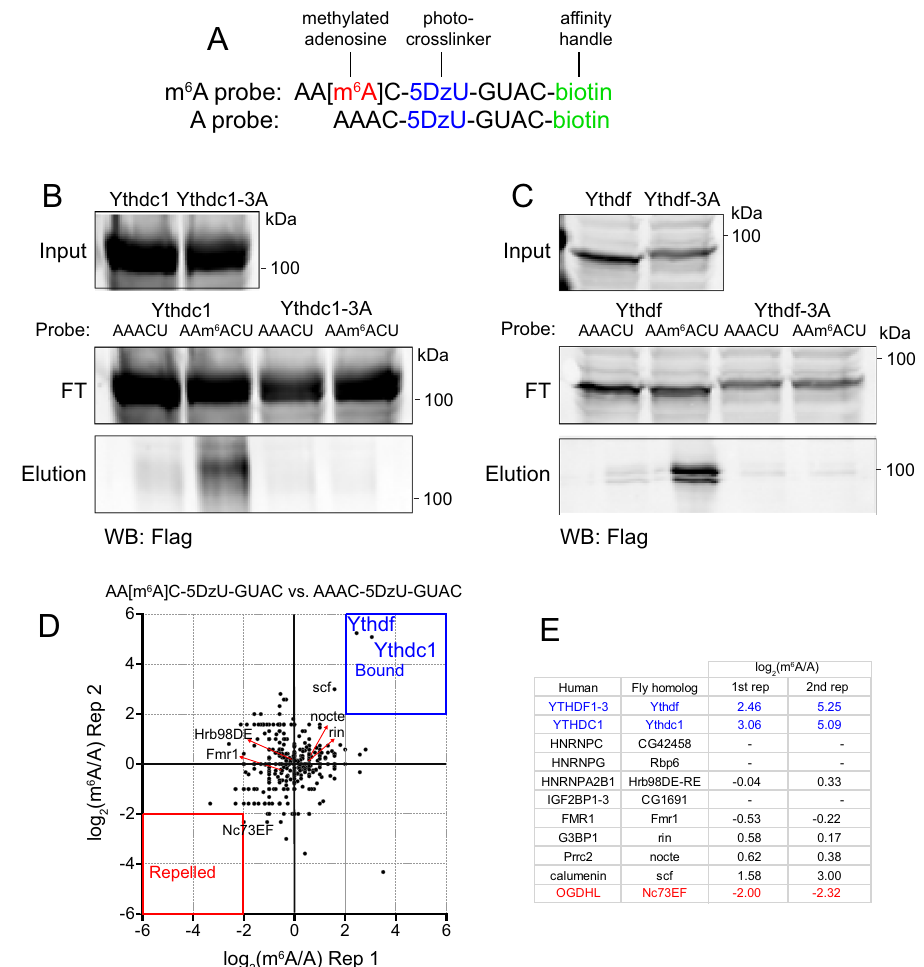
Fig. 1 Ythdc1 and Ythdf are the major m 6 A-binding proteins in Drosophila . A RNA photoaf fi nity probes used in crosslinking assays. B and C Both nuclear (Ythdc1) and cytoplasmic (Ythdf) Drosophila YTH factors speci fi cally recognize m 6 A within the AAm 6 ACU context. Point mutations of aromatic residues that line the m 6 A cage (3A variants) abolish selective binding to m 6 A probes. FT Flow through. Shown is one representative result from two repeats. D Proteomic pro fi ling of S2 cells using m 6 A and A RNA photoaf fi inity probes reveals Ythdc1 and Ythdf as the only preferentially bound (reader) proteins, and no strongly repelled proteins were found in these conditions. Background proteins are clustered together around the plot origin; threshold = 2 X the interquartile range. Two biological replicates were plotted. E Selected values of fl y homologs of mammalian m 6 A readers and repelled proteins expressed in S2 cells, as well as candidates of novel bound/repelled factors. Source data are provided as a Source Data fi le and Supplementary Dataset